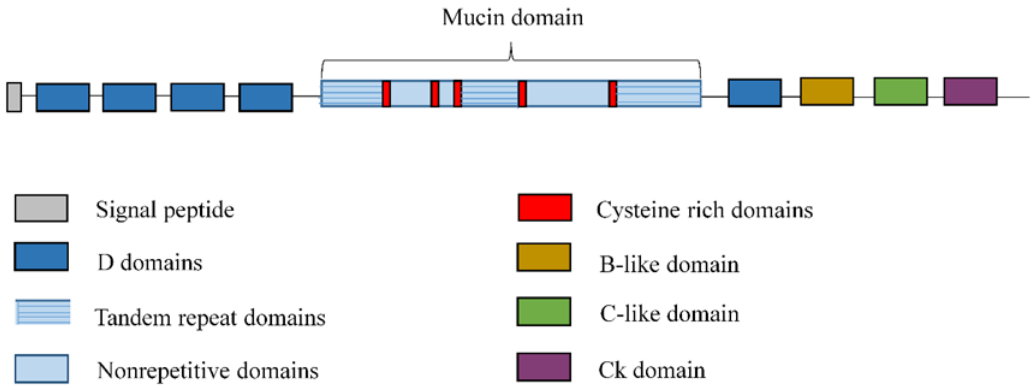
Figure 1. General structure of secreted mucins. Secreted mucins are composed of a large central exon, containing the entire tandem repeat domain, nonrepetitive domains and at least five important cysteine-rich domains, and flanking 5 ′ and 3 ′ regions vonWillebrand factor (vWF)-like domains (D domains, the B domain, the C domain, and the CK domain).